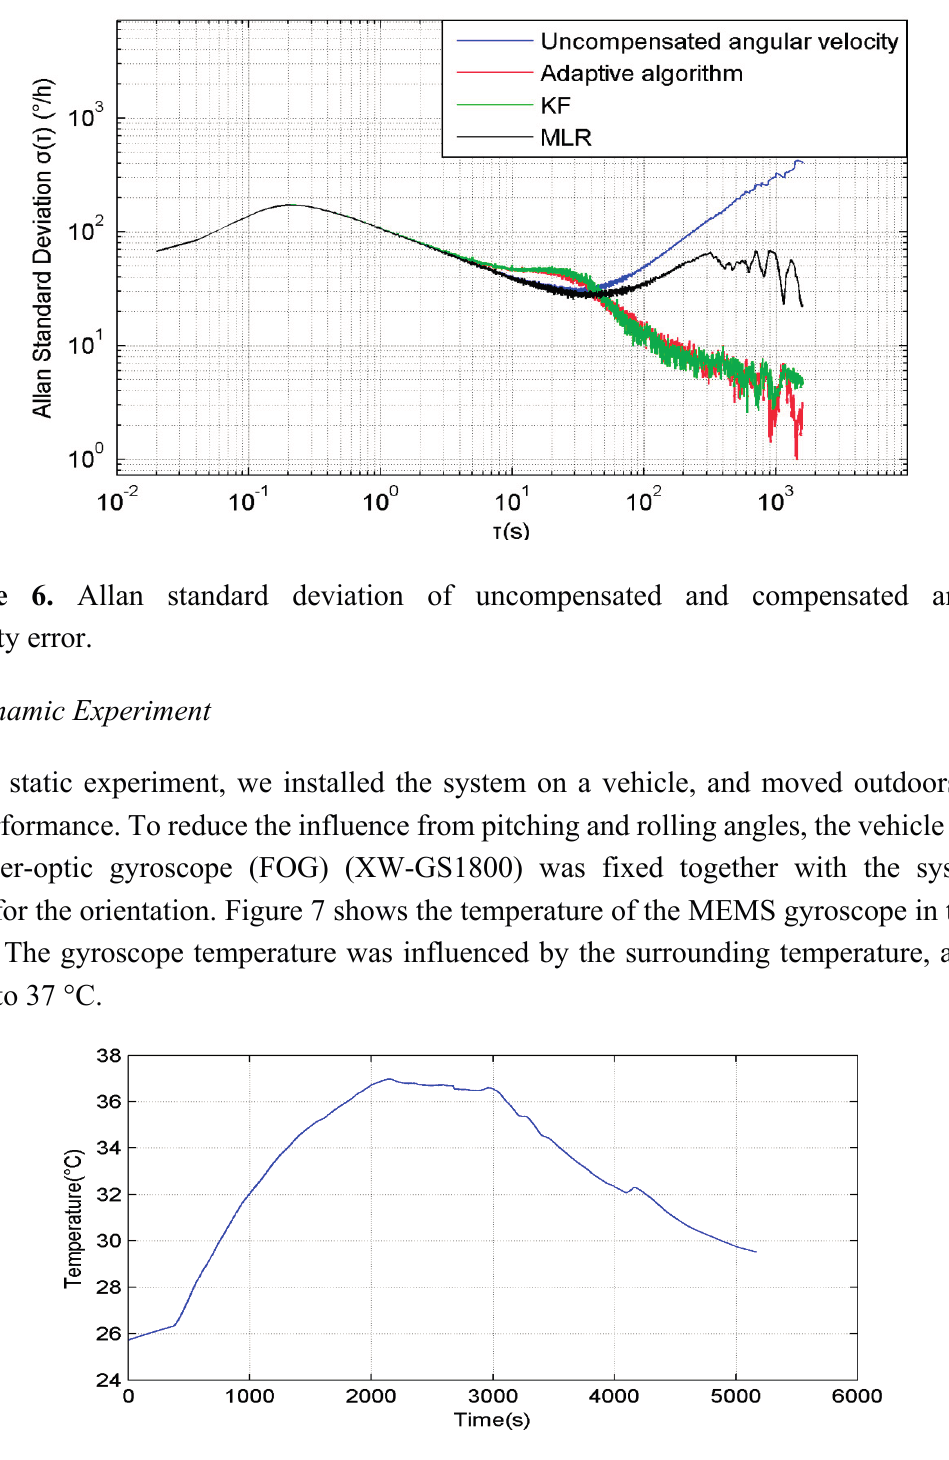
Figure 7. Temperature variation in the entire